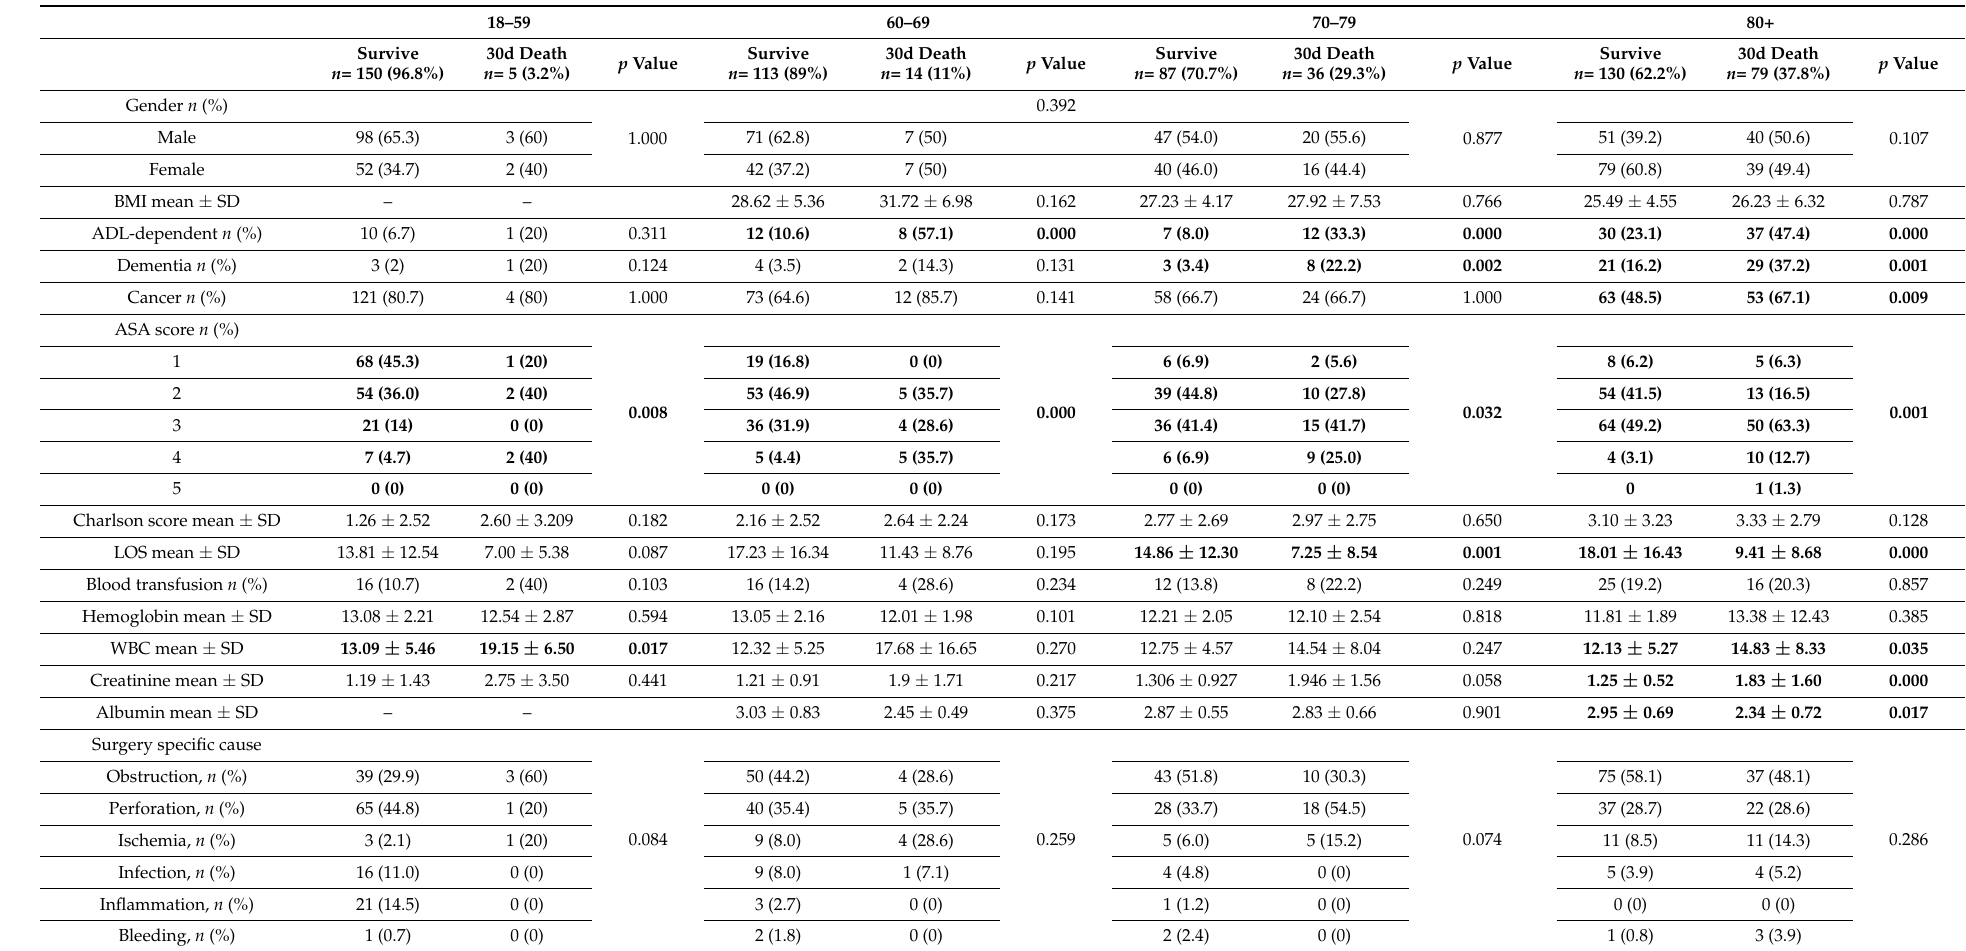
Table 2. Risk-factors for 30-day mortality according to age groups- univariate